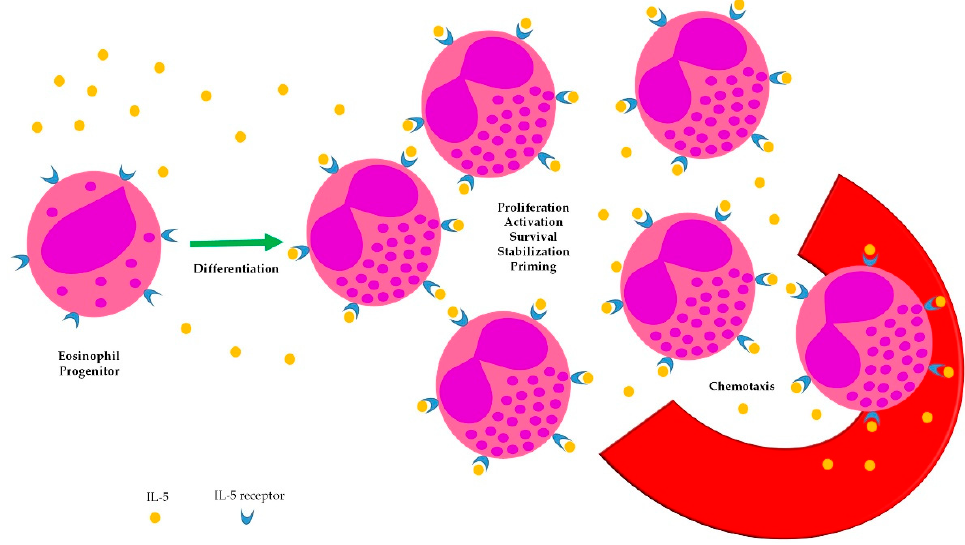
Figure 1. Biologic effects of IL-5 on eosinophils.